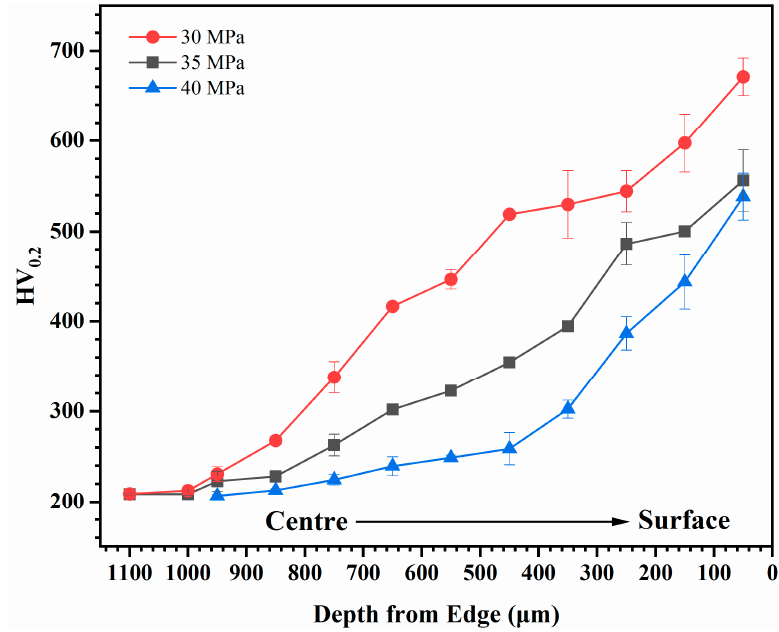
Figure 9. Microhardness distribution with depth from edge of the FeCoCrNiMo HEA after sintering at 1150 ◦ C and 30, 35, and 40